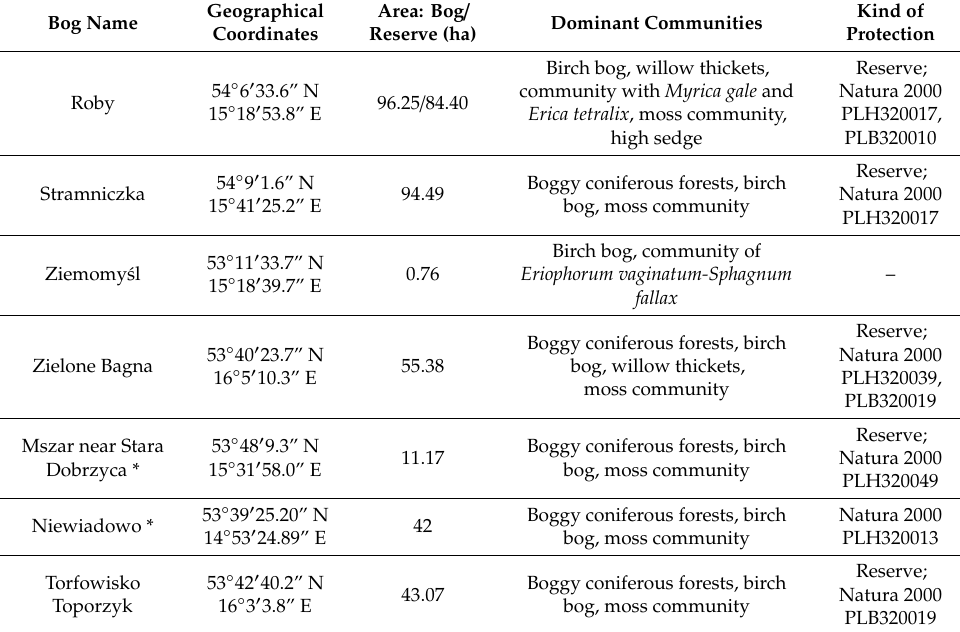
Table 1. Characteristics of the analyzed